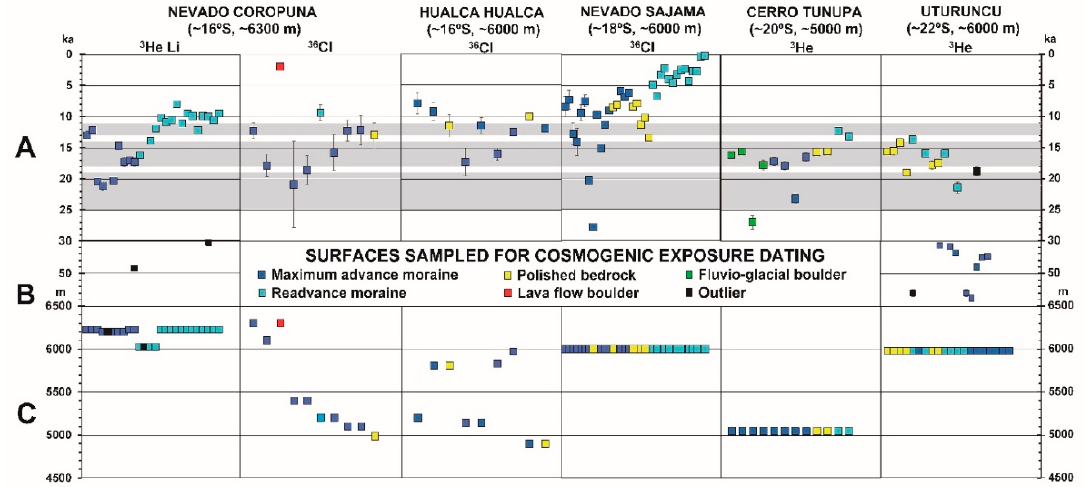
Figure 13. ( A ). Cosmogenic glacial ages in the Arid Tropical Andes (30–0 ka): Coropuna [37,38]; This work; Hualca Hualca [7], Sajama [121] Tunupa [8] and Uturuncu [9]. Gray areas: chronology of lake transgressions on the Bolivian Altiplano [10]. ( B ). Glacial ages between 70 and 30 ka, from Coropuna [37] and Uturuncu [9]. ( C ). Glacier source area altitudes linked to the sampled surfaces.